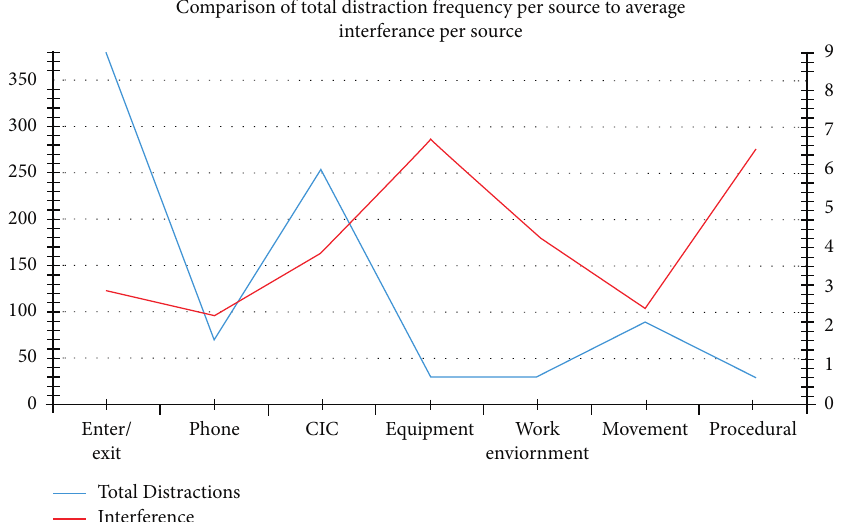
Figure 2: Total observed distractions per source ( n � total number) vs. average interference per source of distraction (scale 1–9).